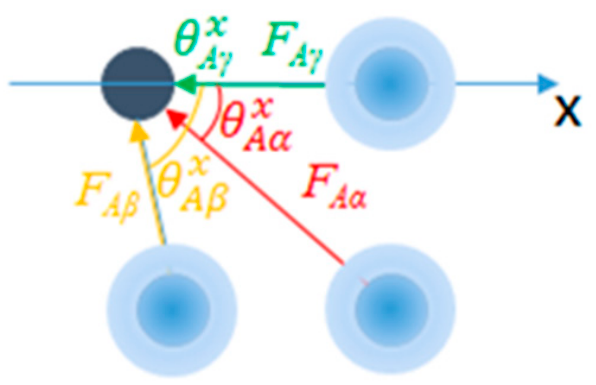
Figure 10. With respect to atom A (dark blue dot on the upper left corner), all atom pairwise contacts on this atom are independent from each other. With atom A moving along the x axis, the ensemble energy.